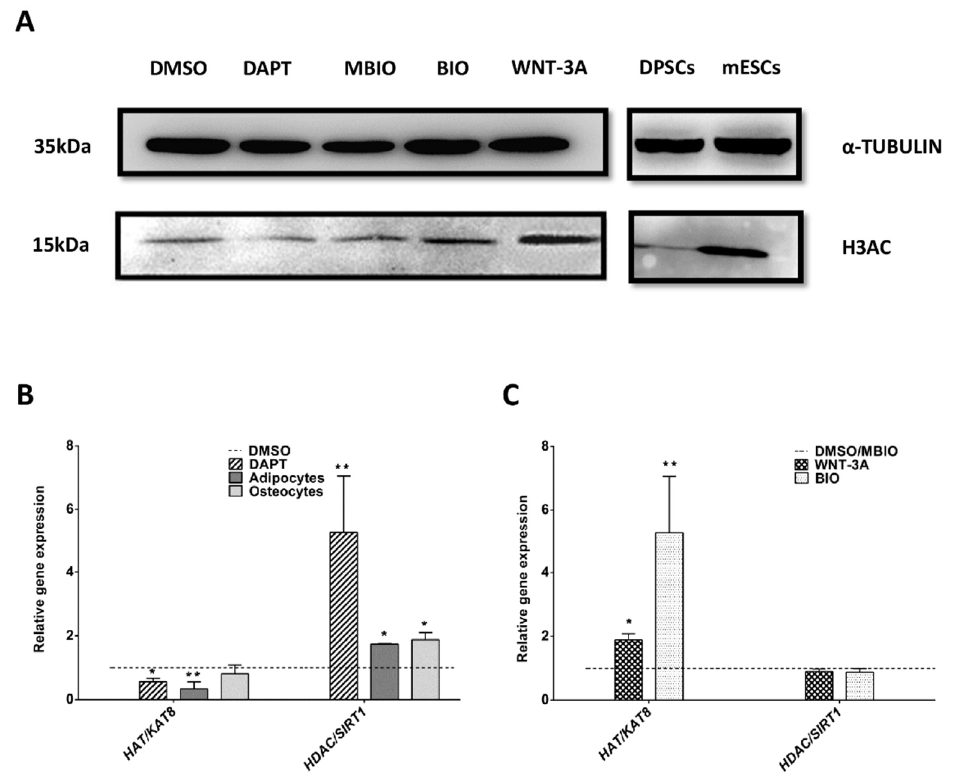
Figure 5. Notch and Wnt signaling a ff ect histone acetylation in DPSCs. ( A ): Representative WB showing H3AC levels in control and treated DPSCs. α -TUBULIN was used as a protein loading control. Mouse ESCs were used as a positive control for high levels of H3 acetylation (right panel). Control on right panel shows untreated DPSCs grown in standard conditions. ( B ): Q-PCR analysis of HAT / KAT8 and HDAC / SIRT1 expression in DAPT-treated and osteo / adipoinduced DPSC cultures. ( C ): Q-PCR analysis of WNT-3A / BIO treated DPSC cultures for HAT / KAT8 and HDAC / SIRT1. Data are normalized to reference β -ACTIN and GAPDH levels and presented as the mean + SEM ( n = 3). *: p < 0.05; **: p < 0.01. Dunn’s Test, Kruskal- Wallis H Test. Asterisks (*) report significance with respect to controls PBS / DMSO, and Hash symbol (#) represents significance with respect to control MBIO.